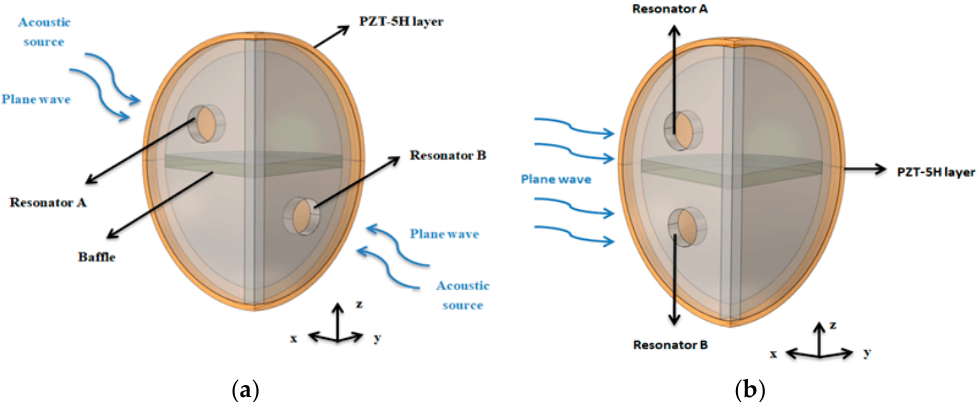
Figure 6. Schematic diagram of ( a ) unidirectional coupled resonators and ( b ) dual-directional coupled resonators.